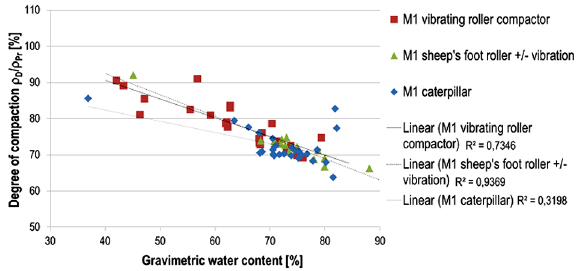
Fig. 9. DOC for M1 and different compaction technologies